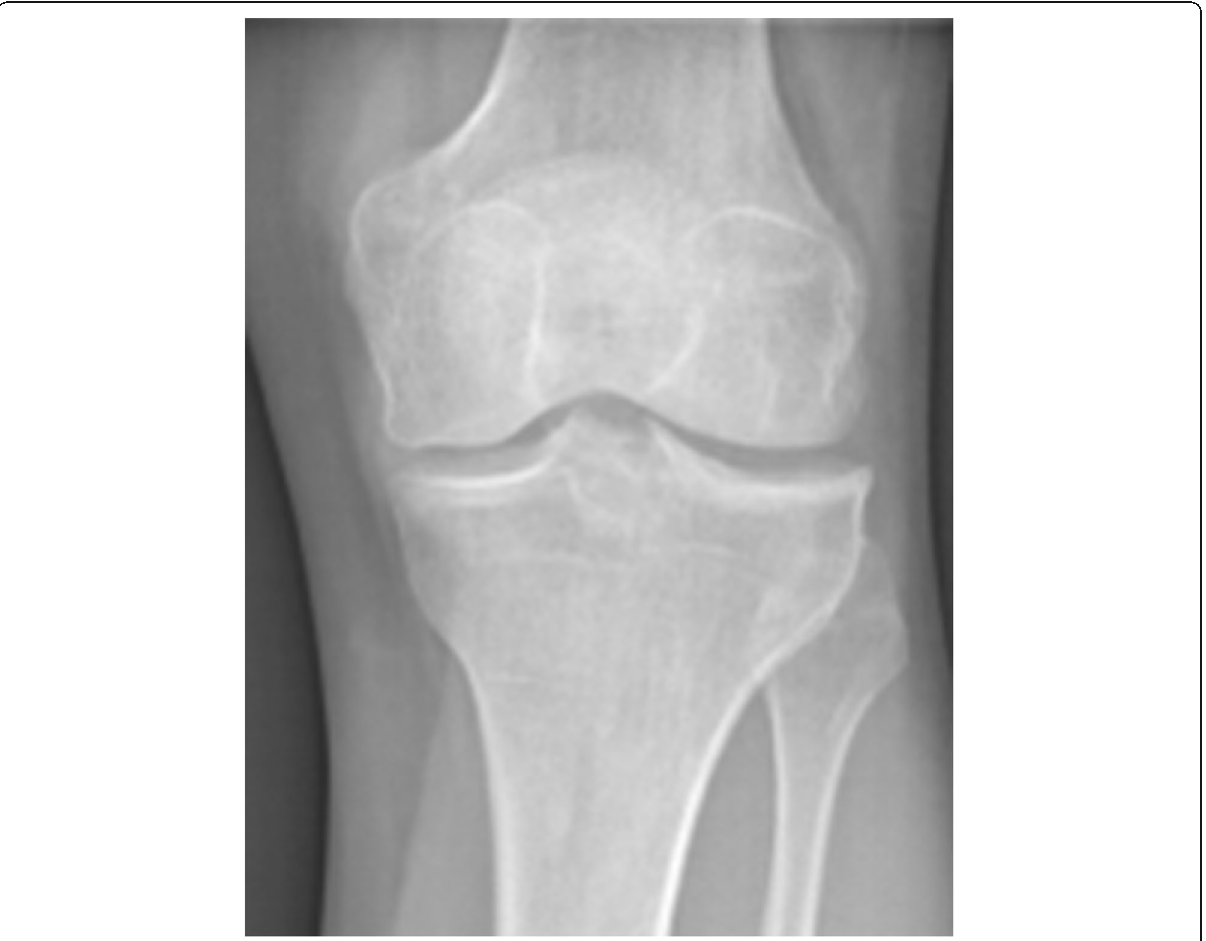
Fig. 5 Pre-operative AP knee radiography Patient